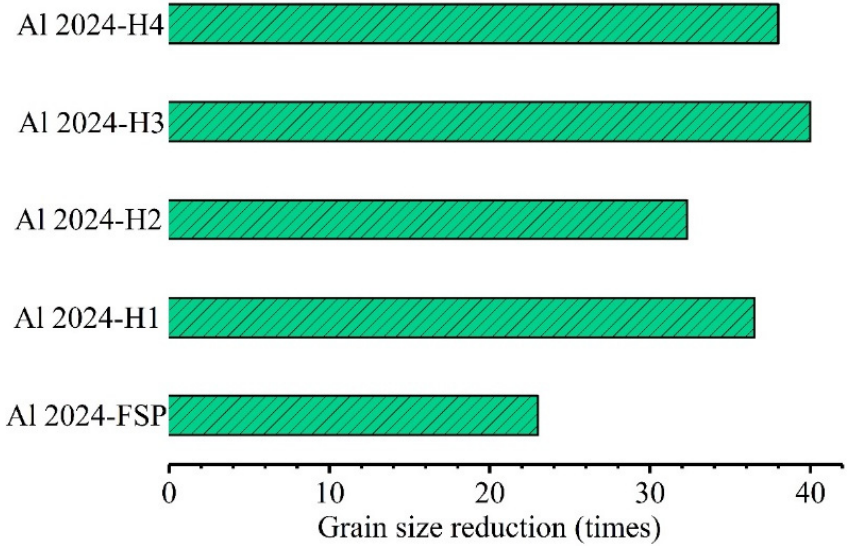
Figure 6. Grain size refinement with respect to base alloy, Al 2024 aluminum alloy.